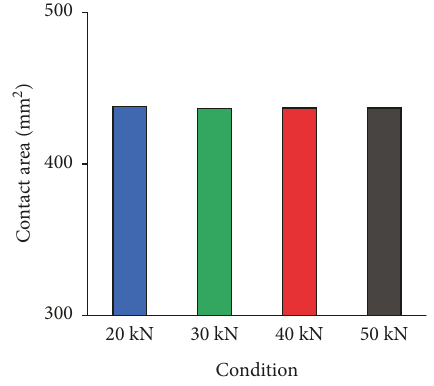
Figure 11: Contact area under different velocities.